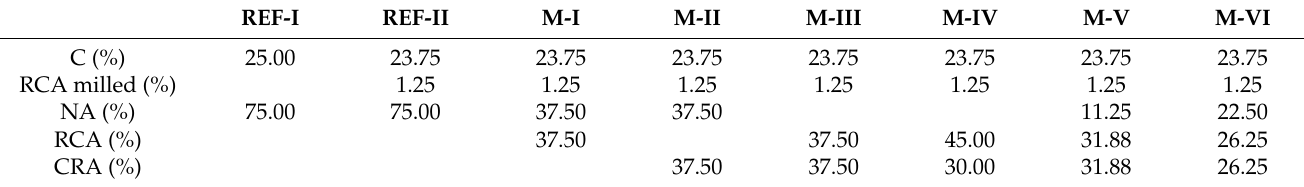
Table 1. Mortar mixtures. C—cement, NA—natural aggregate, RCAs—recycled concrete aggregates, CRAs—recycled ceramic